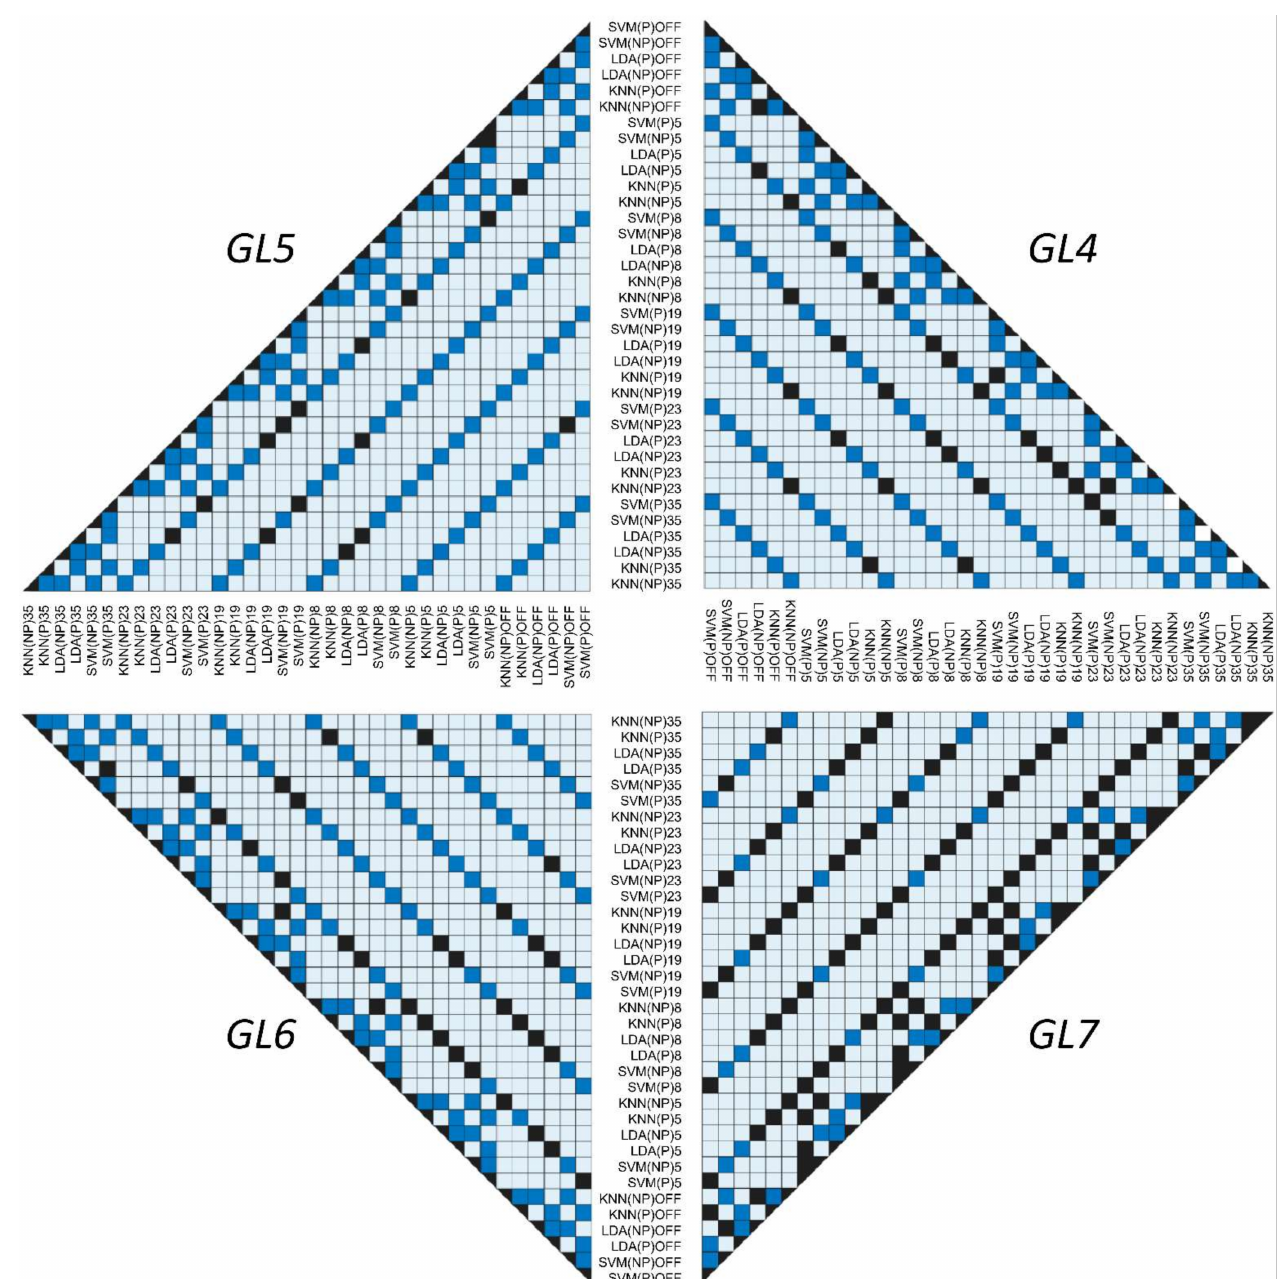
Figure 7. Testing difference between classifiers (SVM, LDA, and k-NN) using a paired t -test among paretic and non-paretic sides with and without the use of PCA: right top is GL4 , left top is GL5 , left bottom is GL6 , and right bottom is GL7 model. The dark-blue squares indicate a significance between the assessed pairs of classifiers ( p < 0.05) and black color shows non-significance ( p >